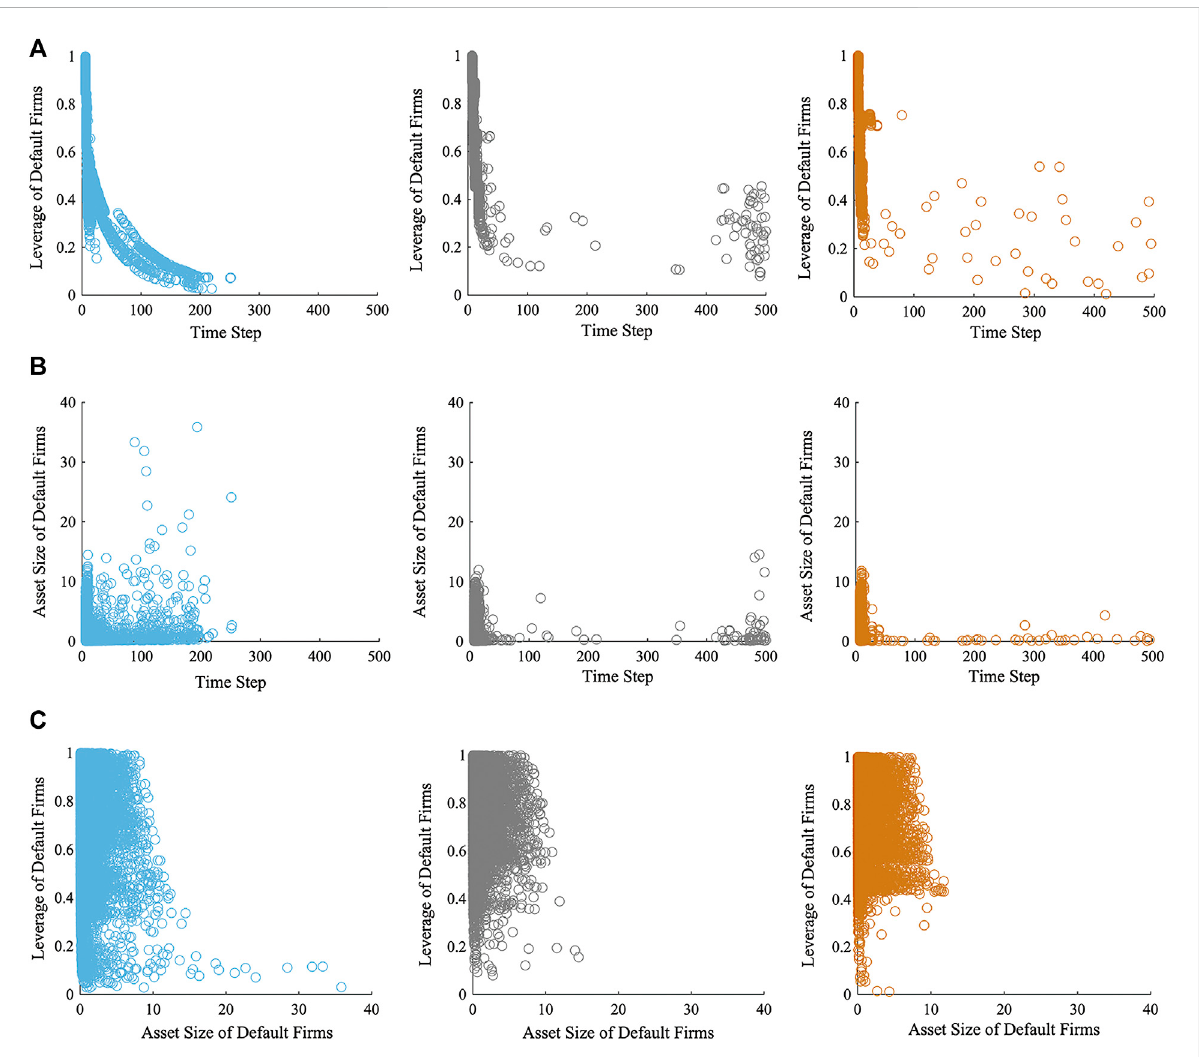
FIGURE 3 (A) The leverage of each default fi rm and the time step of its default; (B) The asset size of each default fi rm and the time step of its default; (C) Scatter plot between the asset size and its leverage of each default fi rm. Blue, gray and orange represent macroeconomic fl uctuations in upward, downward and random trends,